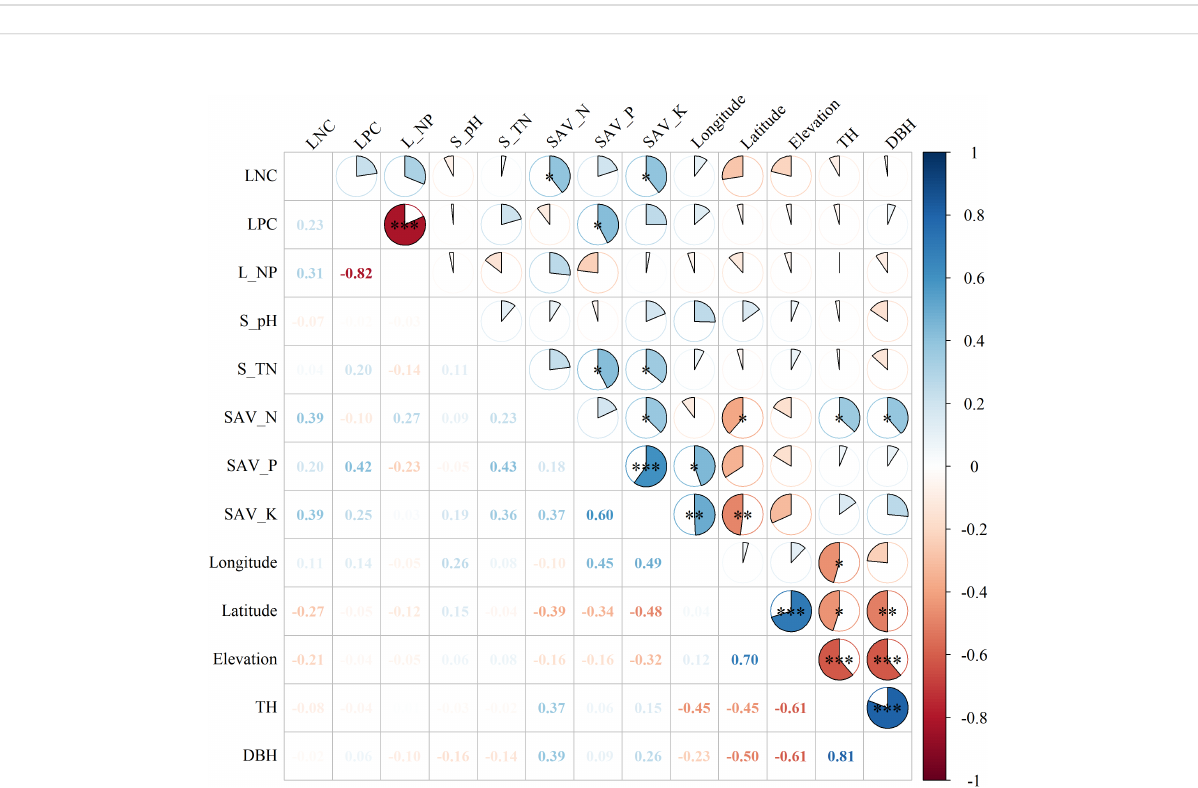
FIGURE 2 Pearson ’ s correlation matrix of leaf nutrition and environmental explanatory variables. Note: S_pH, S_TN, SAV_N, SAV_P, SAV_K, TH, and DBH represent soil pH, soil total nitrogen, soil available nitrogen, soil available phosphorus, soil available potassium, tree height, and DBH, respectively. Asterisk (*) indicated signi fi cant correlation with *, ** and *** indicating signi fi cance levels at 0.05 0.01 and 0.001,